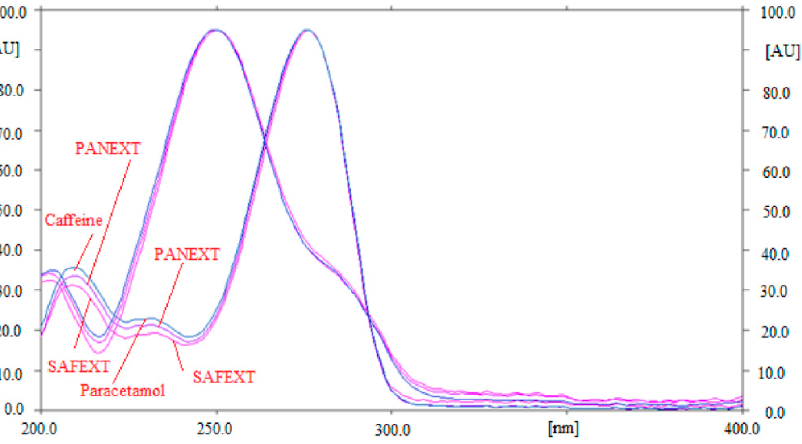
Figure 5. Superimposed ultra-violet (UV) absorption spectra of standard caffeine and paracetamol and caffeine and paracetamol in PANEXT and SAFEXT.